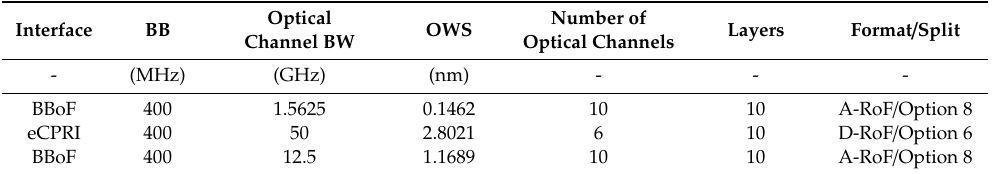
Table 4. Calculated comparative parameters for detailed scenario No. 2 to switch from D-RoF to A-RoF format (the optical channel count-down is starting from wavelength equal to 1675 nm)—Figures 10 and 12 (128-element antenna-array and 4-sector unit).